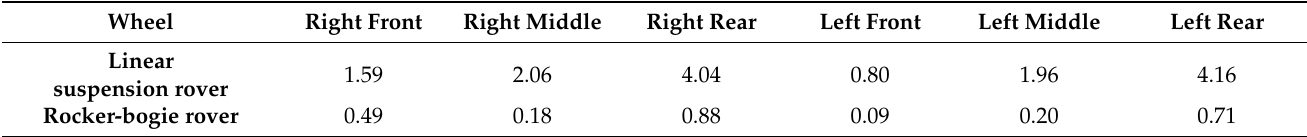
Table 4. Duration for which the contact force was equal to